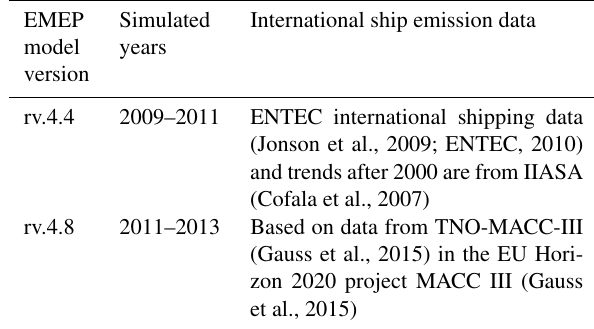
Table 1. International ship emission data for the different versions of the EMEP model used in this